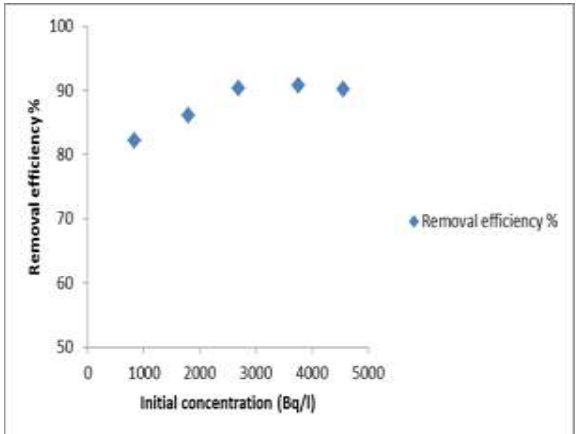
Fig.6: Effect of initial concentration on the removal efficiency of cesium .